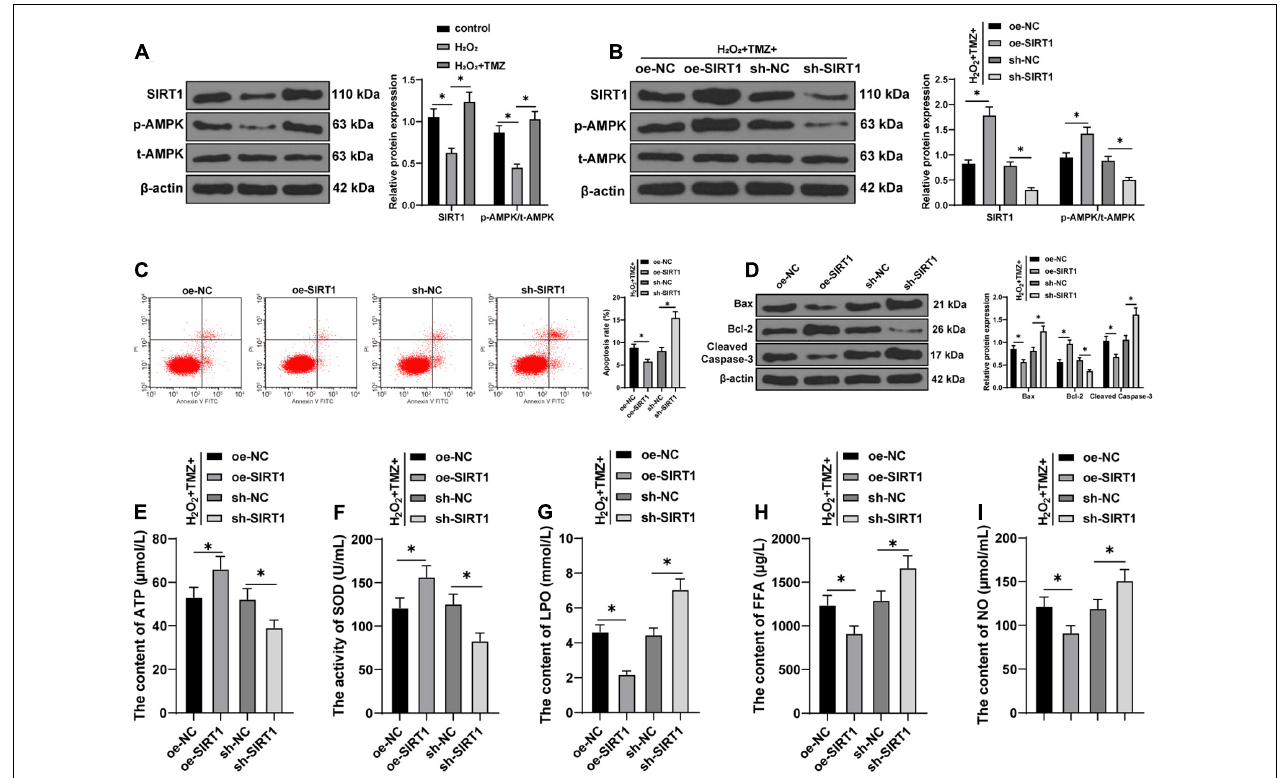
FIGURE 4 | Trimetazidine inhibited H 2 O 2 -induced cardiomyocyte apoptosis and energy metabolism disorder via the SIRT1–AMPK pathway. (A) Western blot analysis of SIRT1, p-AMPK, and t-AMPK. (B) Western blot analysis of SIRT1, p-AMPK, and t-AMPK after overexpressing or silencing SIRT1 in H9C2 cardiomyocytes jointly processed by H 2 O 2 and TMZ. (C) Flow cytometry analysis for apoptosis. (D) Western blot analysis of Bax, Bcl-2, and cleaved caspase-3. (E) ATP content in H9C2 cardiomyocytes. (F) SOD activity in H9C2 cardiomyocytes. (G–I) Contents of LPO (G) , FFA (H) , and NO (I) in H9C2 cardiomyocytes. Cell experiment was repeated three times. All data were expressed as the mean ± standard deviation. Data were analyzed using one-way ANOVA, followed by Tukey’s multiple comparisons test. * P < 0.05. ATP, adenosine triphosphate; SOD, superoxide dismutase; LPO, lipid peroxide; FFA, free fatty acids; NO, nitric